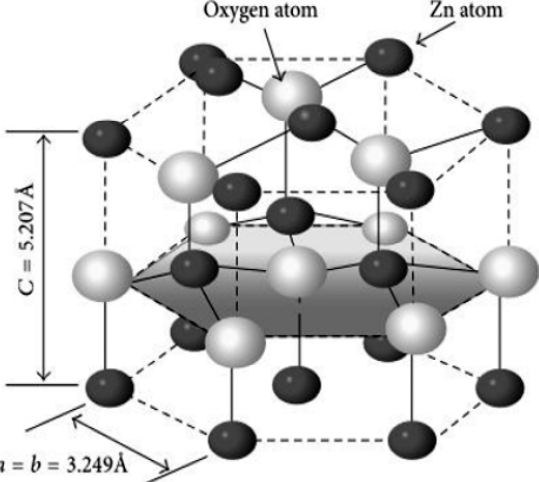
Fig. 2. Crystalline Structure of ZnO